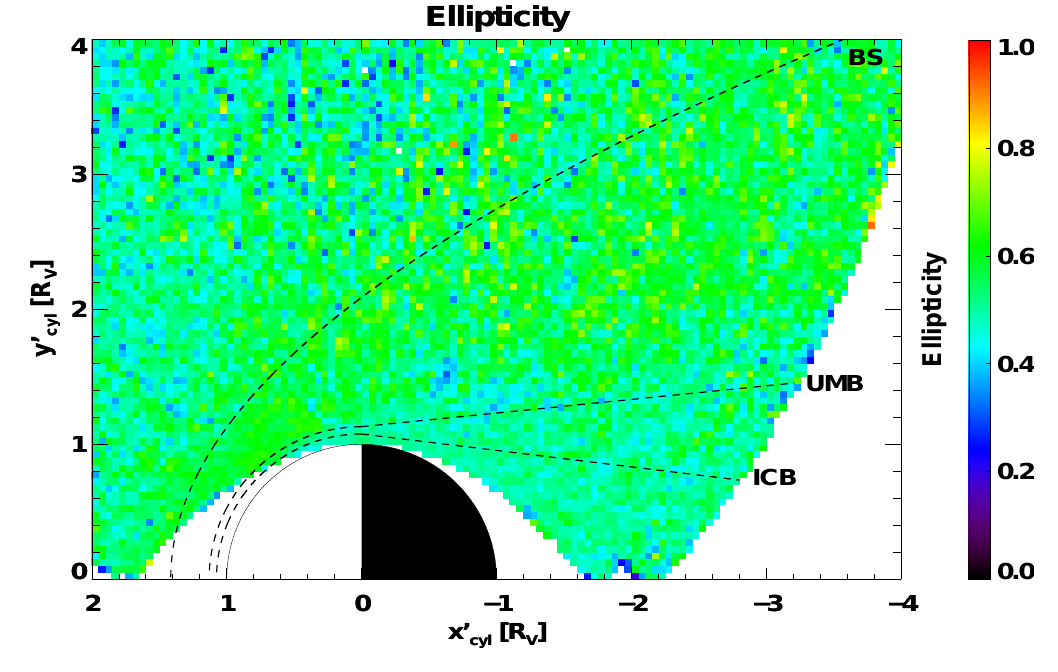
Fig. 5. Ellipticity of the waves in the space plasma environment surrounding Venus. The value (cid:15) = 0 denotes a pure linear polarisation and (cid:15) = 1 a pure circular